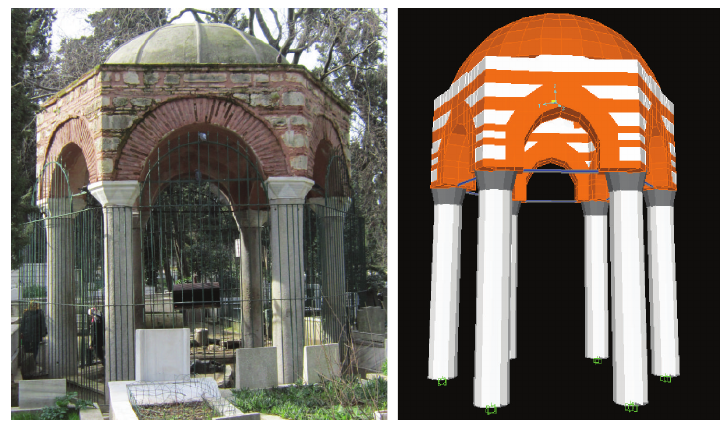
Figure 3: Nis¸ancı Hamza Pas¸a tomb and its FEM simulation.